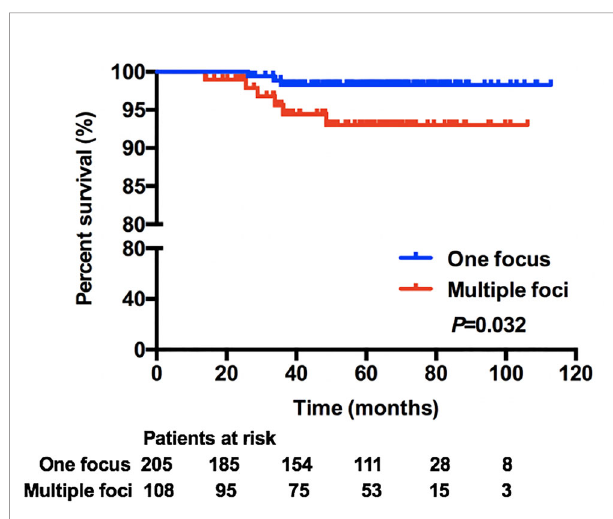
FIGURE 1 | Comparison of DFS between one-focus and multiple-foci patients.